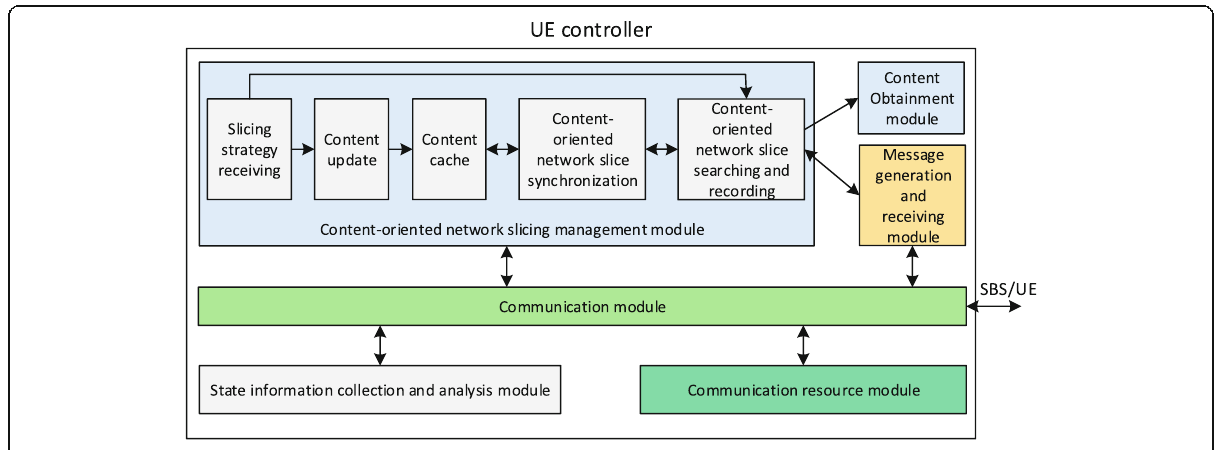
Fig. 6 The functional modules in a UE